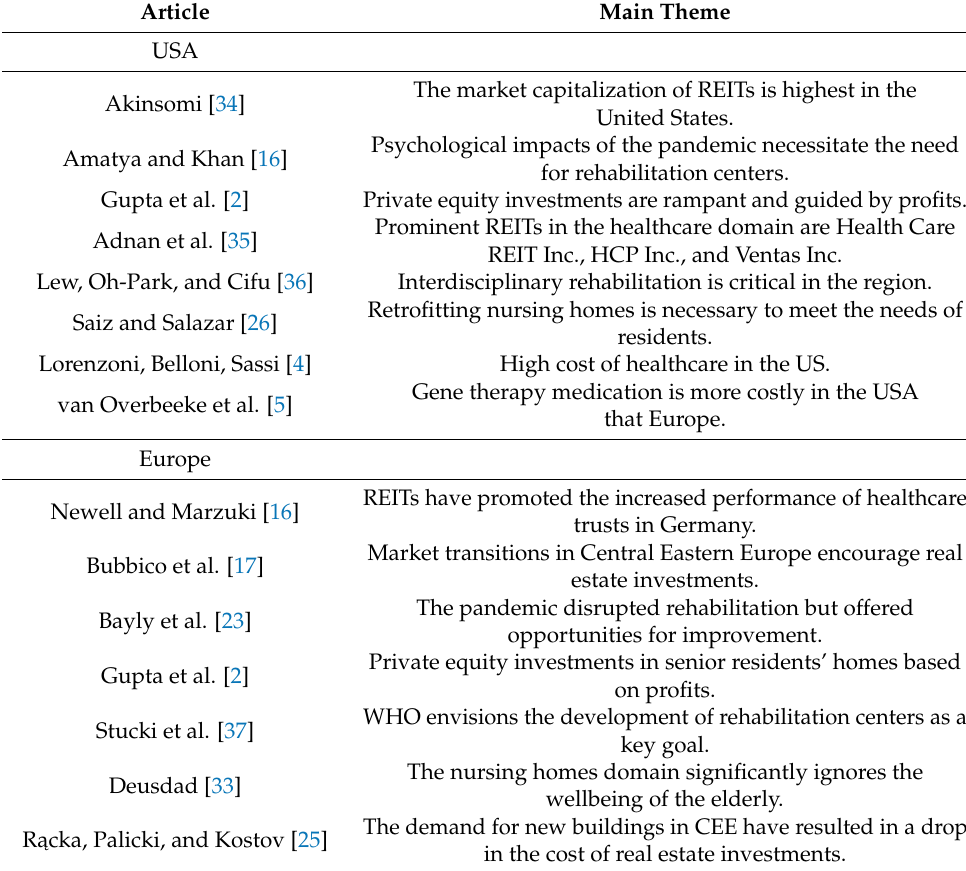
Table 1. Comparison of the USA and Europe real estate investment in